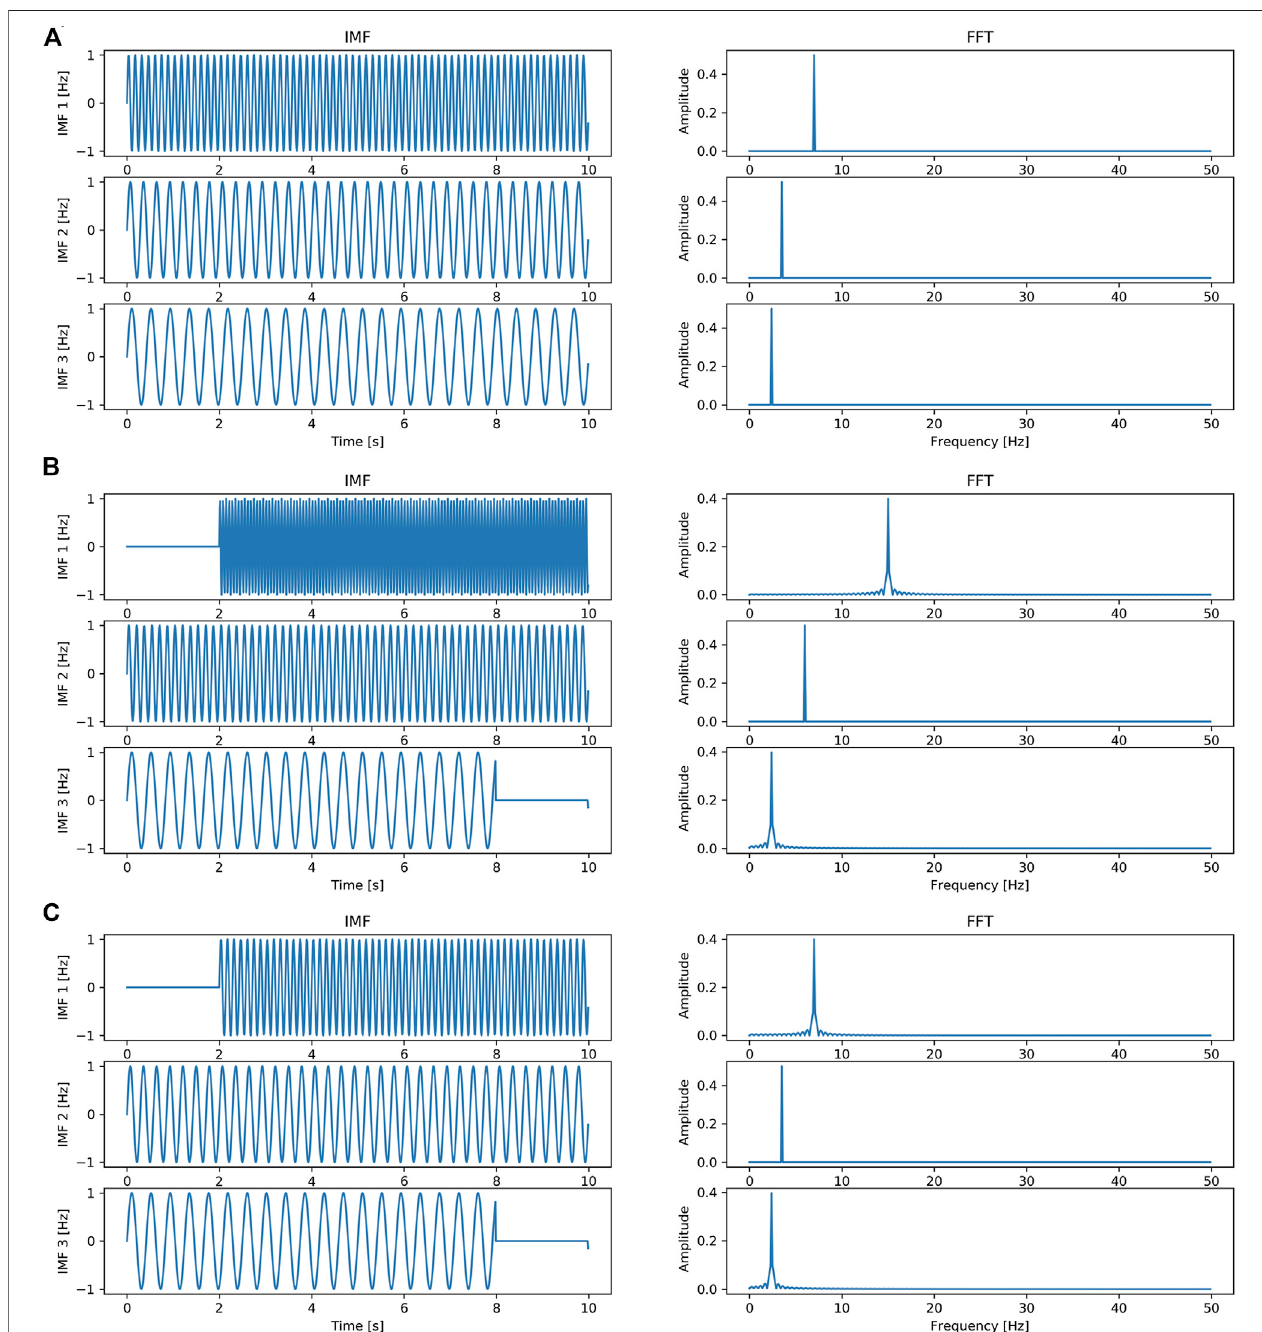
FIGURE 7 | HM-EMD results of x 1 (t), x 2 (t), x 3 (t), (A) IMFs of x 1 (t) and the FFT spectrum of each corresponding IMF; (B) IMFs of x 2 (t) and the FFT spectrum of each corresponding IMF; (C) IMFs of x 3 (t) and the FFT spectrum of each corresponding IMF.